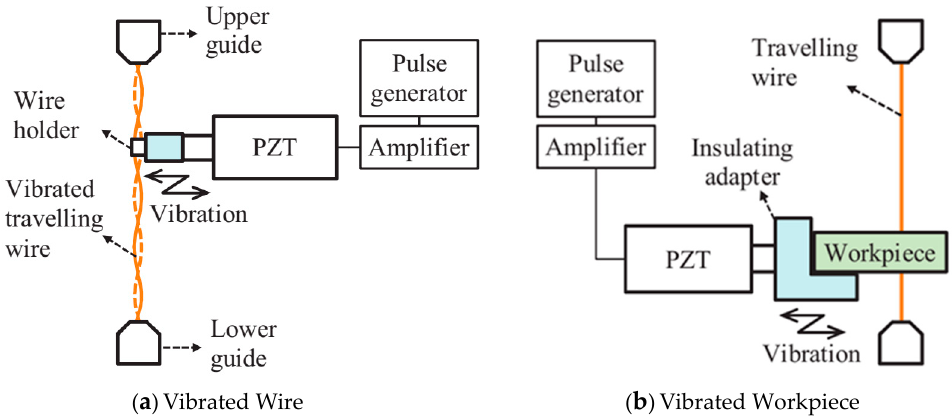
Figure 2 . Schematic diagram of the ultrasonic setup for vibration in WEDM ( a ) wire and ( b ) workpiece [ 21 ]. Reproduced with permission from Hoang, K.T.; Yang, S.H., Mater. Process. Technol.; [18]. published by Elsevier, 2013.